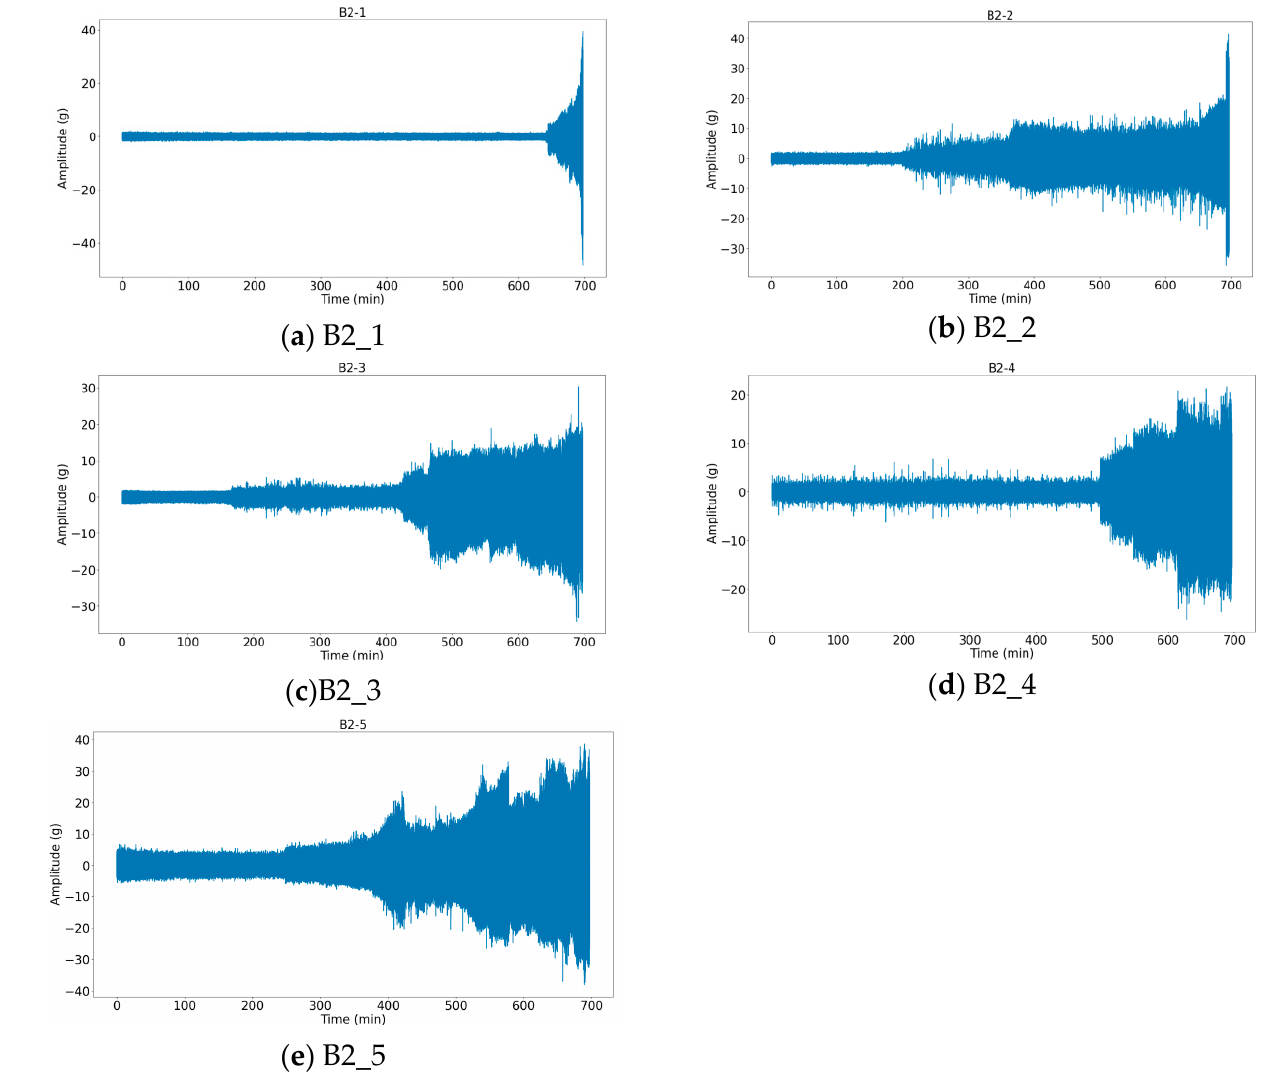
10 Table 3. XJTU-SY datasets of bearings under working condition 2. Working Con- dition